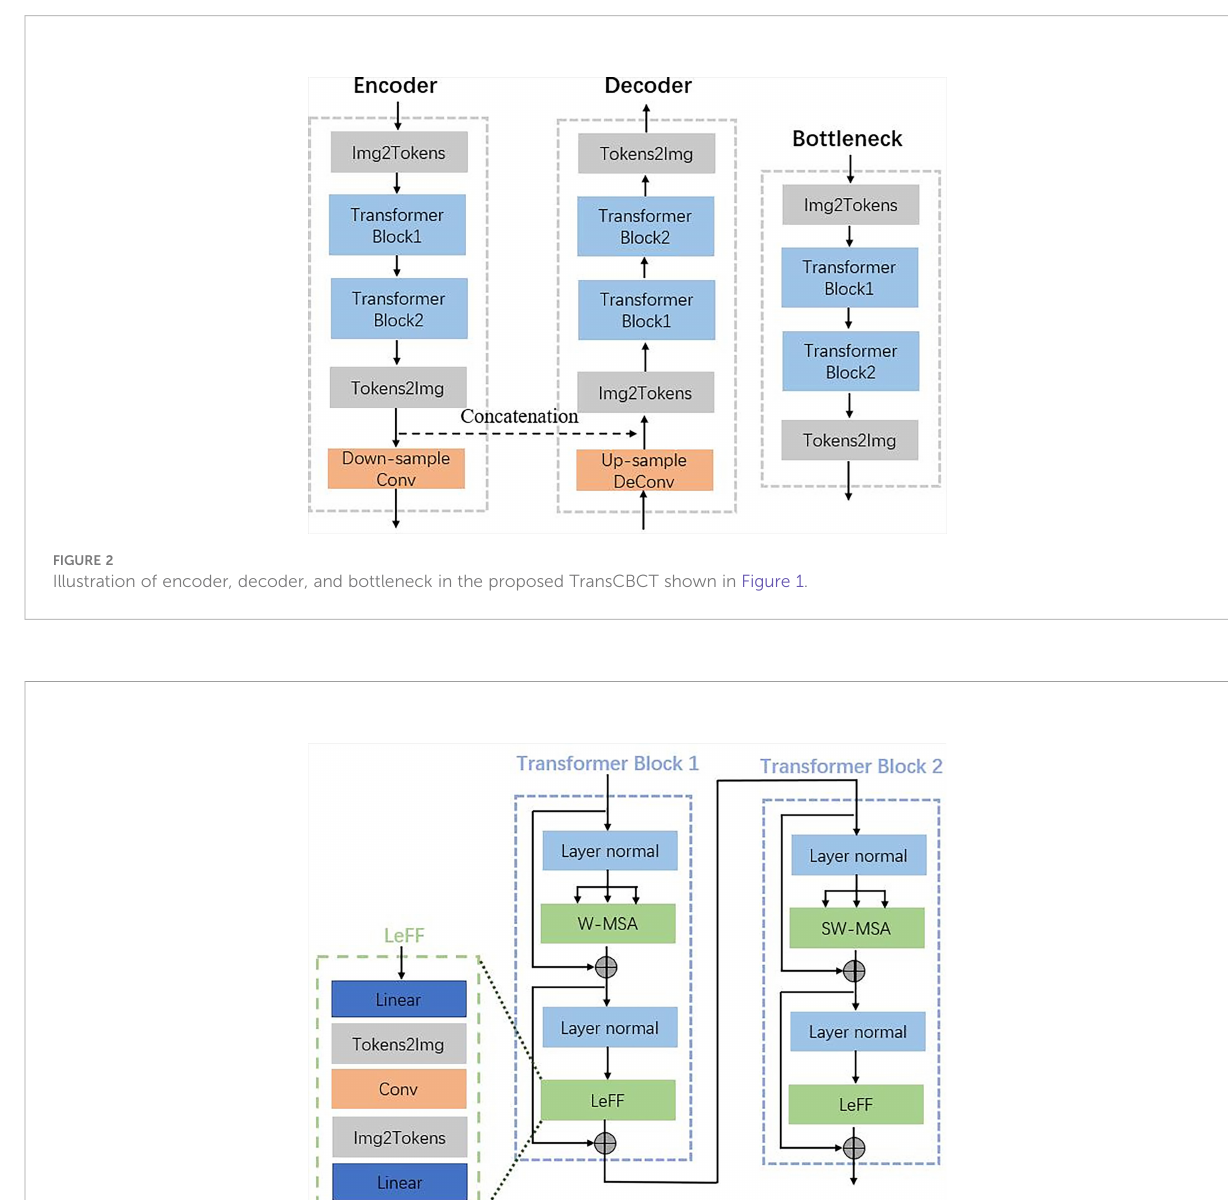
attention on the fl attened features in each window. When computing self-attention, the head number is k , and the head dimension is d = C / k . We included relative position bias B to each head in computing similarity: where Q , K , and V are the query, key, and value matrices. Moreover, Q , K , V , and B are learning parameters. The